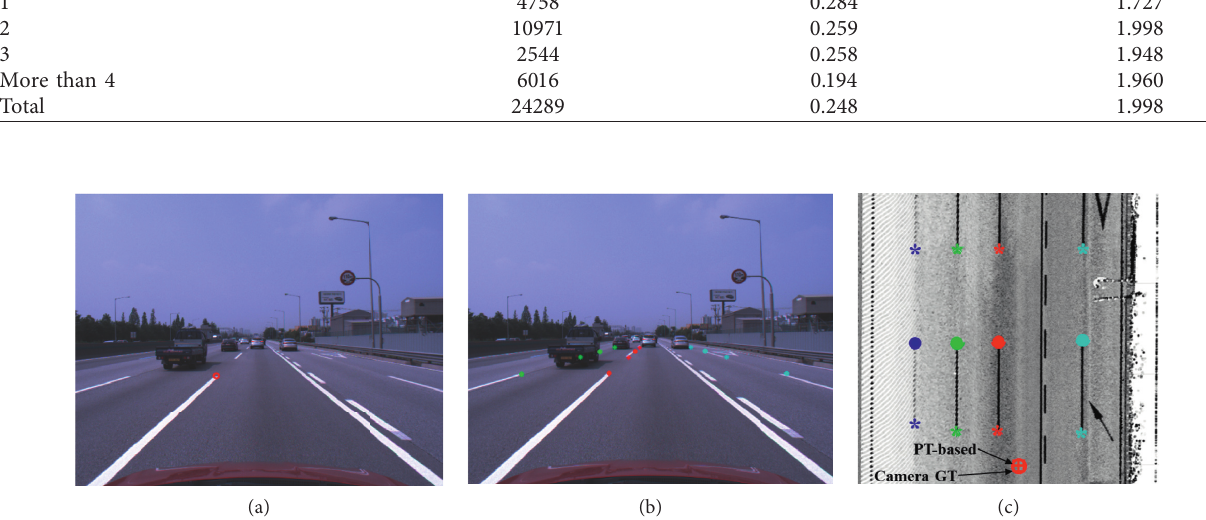
Figure 13: Example of estimated camera position with one detected lane endpoint: (a) detected lane endpoint; (b) projected lane endpoints from a map; (c) estimated camera position.